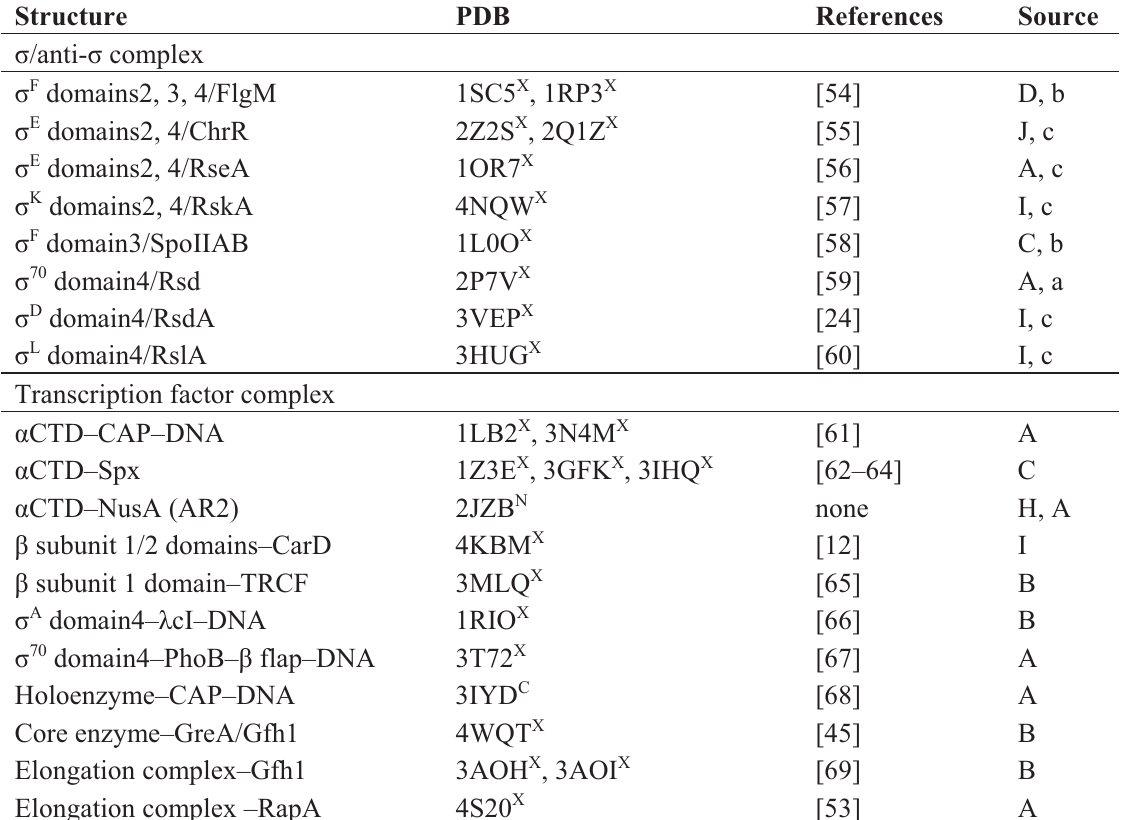
Table 2. Structural information on bacterial RNAP and transcription factor